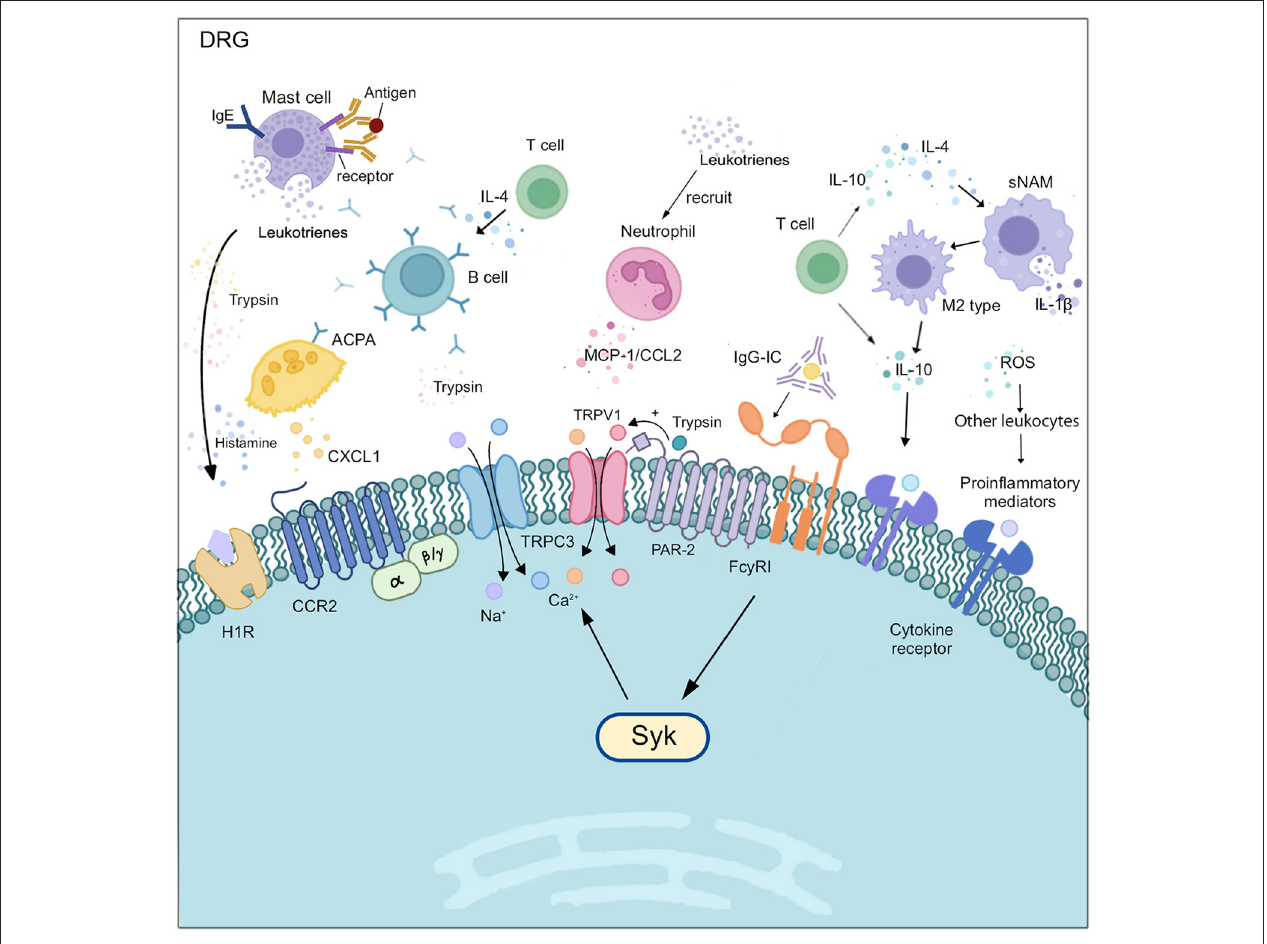
FIGURE 3 | Various immune cells interact with a nociceptive neuron in DRG. In DRG, macrophages, neutrophils, and mast cells secret corresponding cytokines to activate the excitability of sensory neurons and recruit more leukocytes. B cells produce antibodies and initiate consequent activation of nociceptive neurons. Meanwhile, T cells modulate B cells and macrophages through IL-4 or IL-10, and also interact with nociceptive